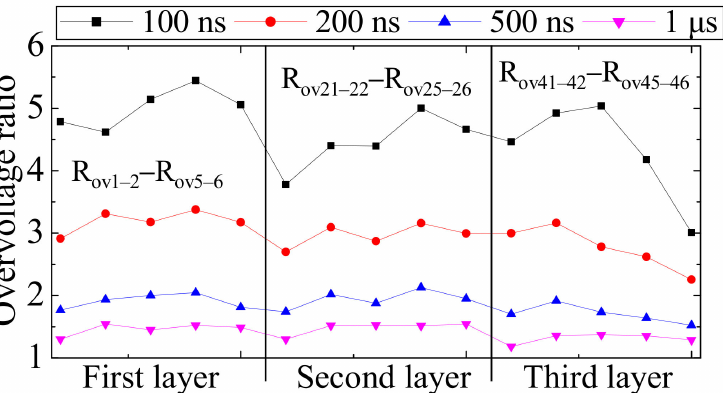
Figure 14. Interturn overvoltage ratio between adjacent turns under different rise times ( E r = 3.9, C-type).